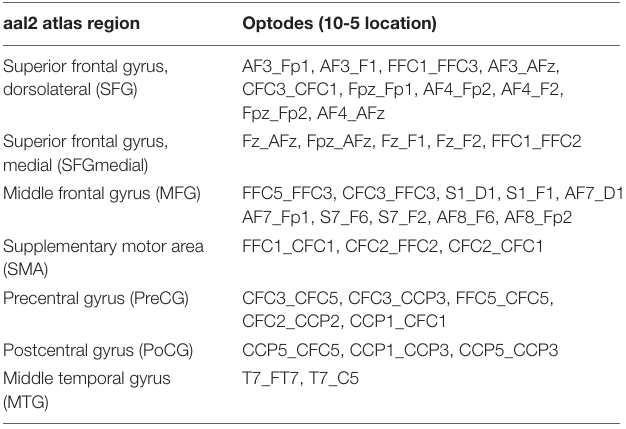
TABLE 3 | Assignment of channels (i.e., source-detector pairs) in the head probe to aal2 atlas regions (Tzourio-Mazoyer et al., 2002; Rolls et al., 2015) based on maximum probabilities as derived from fOLD (Zimeo Morais et al.,